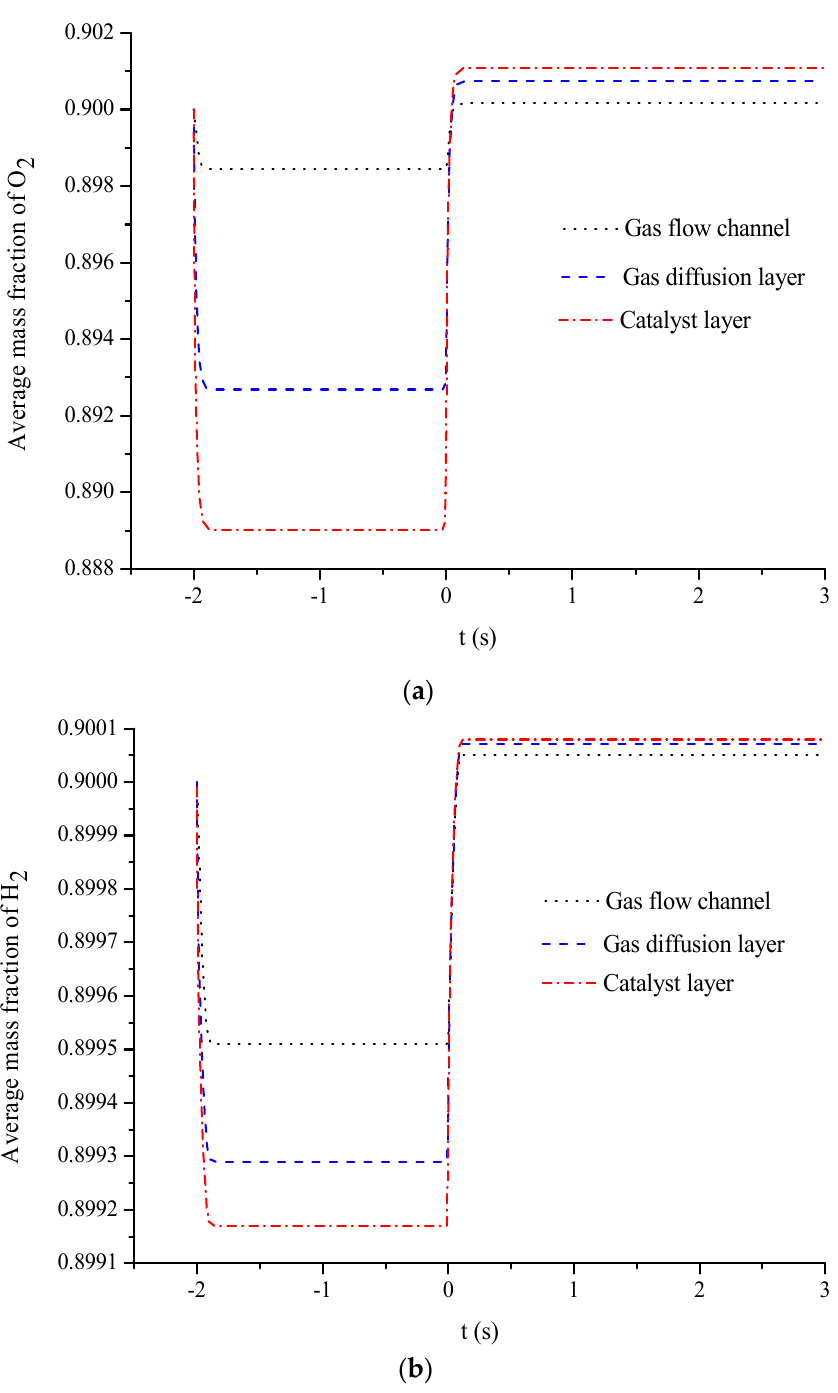
Figure 9. Time ‐ dependent evolution of H 2 O mass fraction in different layers. Figure 10a,b show the 2D distributions of O 2 , H 2 , and H 2 O mass fractions at − 0.01 s before the operation mode switching. The cell is in the steady state at − 0.01 s according to the Figure 8. Hydrogen mass fraction is distributed uniformly in each layer. On one hand, the electrochemical reaction consumes a little hydrogen, which results in a little reduction in the mass fraction. On the other hand, the excessive hydrogen is provided in the H 2 side gas flow channel, and is rapidly diffused on the surface of CL, a large amount of hydrogen is evenly distributed on the catalyst surface. The oxygen mass fraction decreases with an evident gradient from the gas flow channel to the CL at the oxygen side. However, the water mass fraction exhibits a different trend compared with hydrogen and oxygen; it increases distinctly from the gas flow channel to the CL. Figure 10c,d show the 2D distributions of O 2 , H 2 , and H 2 O mass fractions at 0.01 s after the switching of the FC mode towards